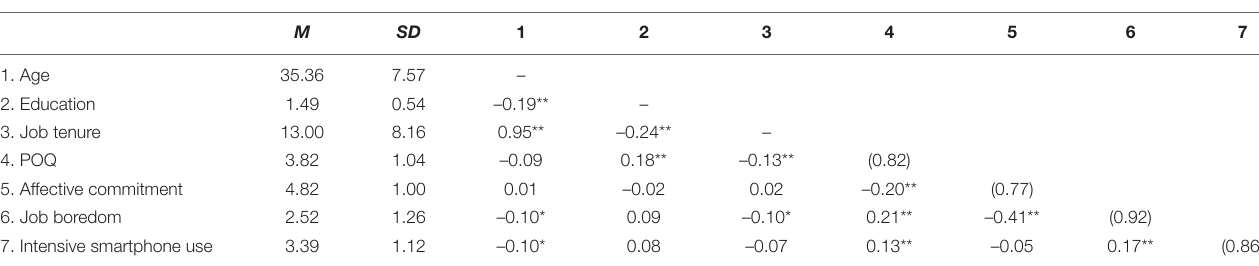
TABLE 1 | Descriptive statistics and correlations between variables.